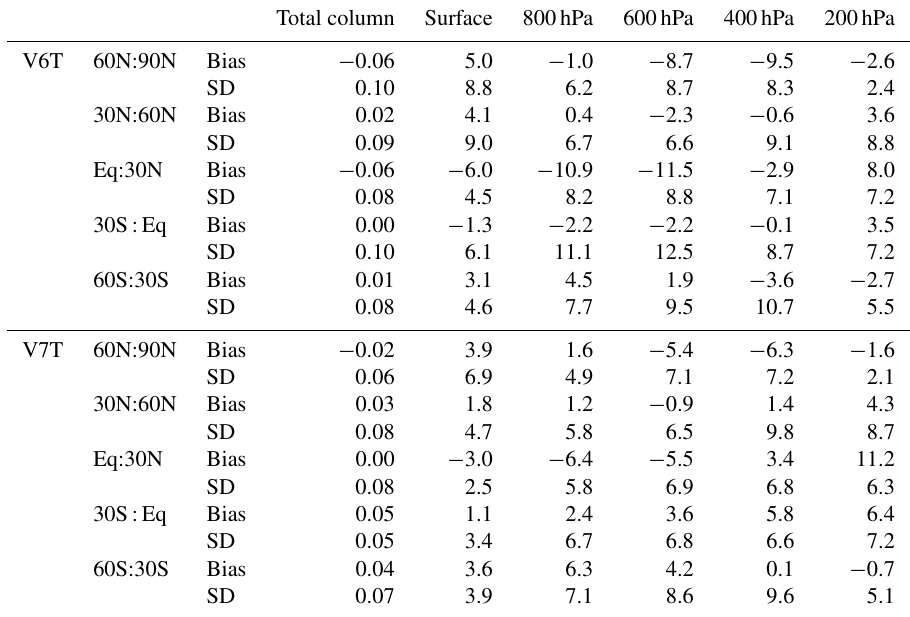
Table 3. Latitude dependence of validation results for V6T and V7T products based on in situ data from the HIPPO field campaign. See caption to Table 1.